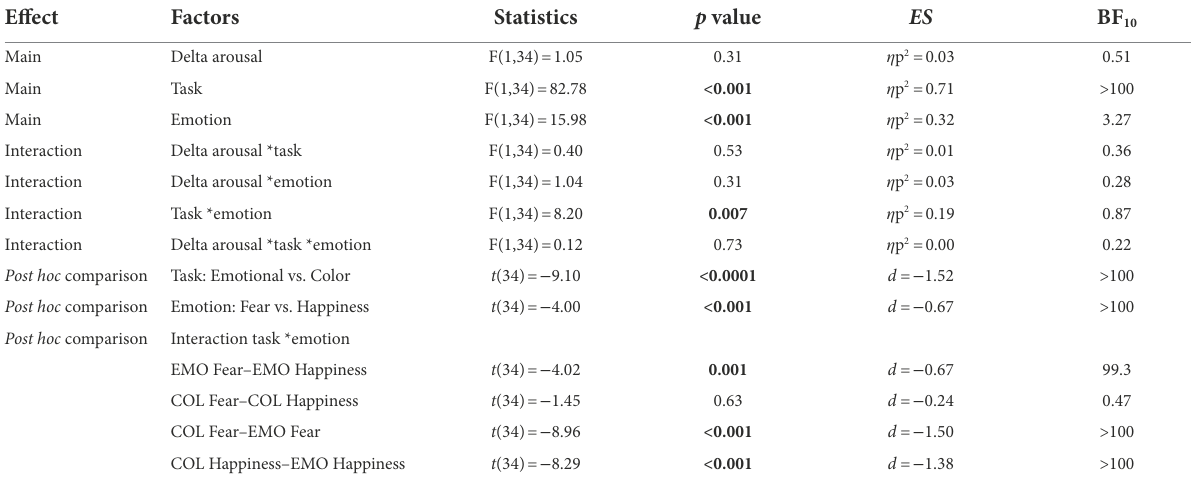
TABLE 1 Results of the statistical analyses on commission error